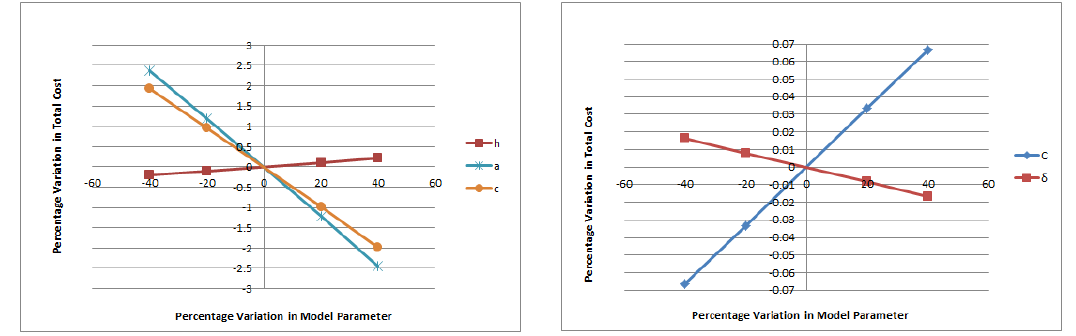
Figure 1: Percentage Variation in Model Parameters with Percentage Variation in Total Cost